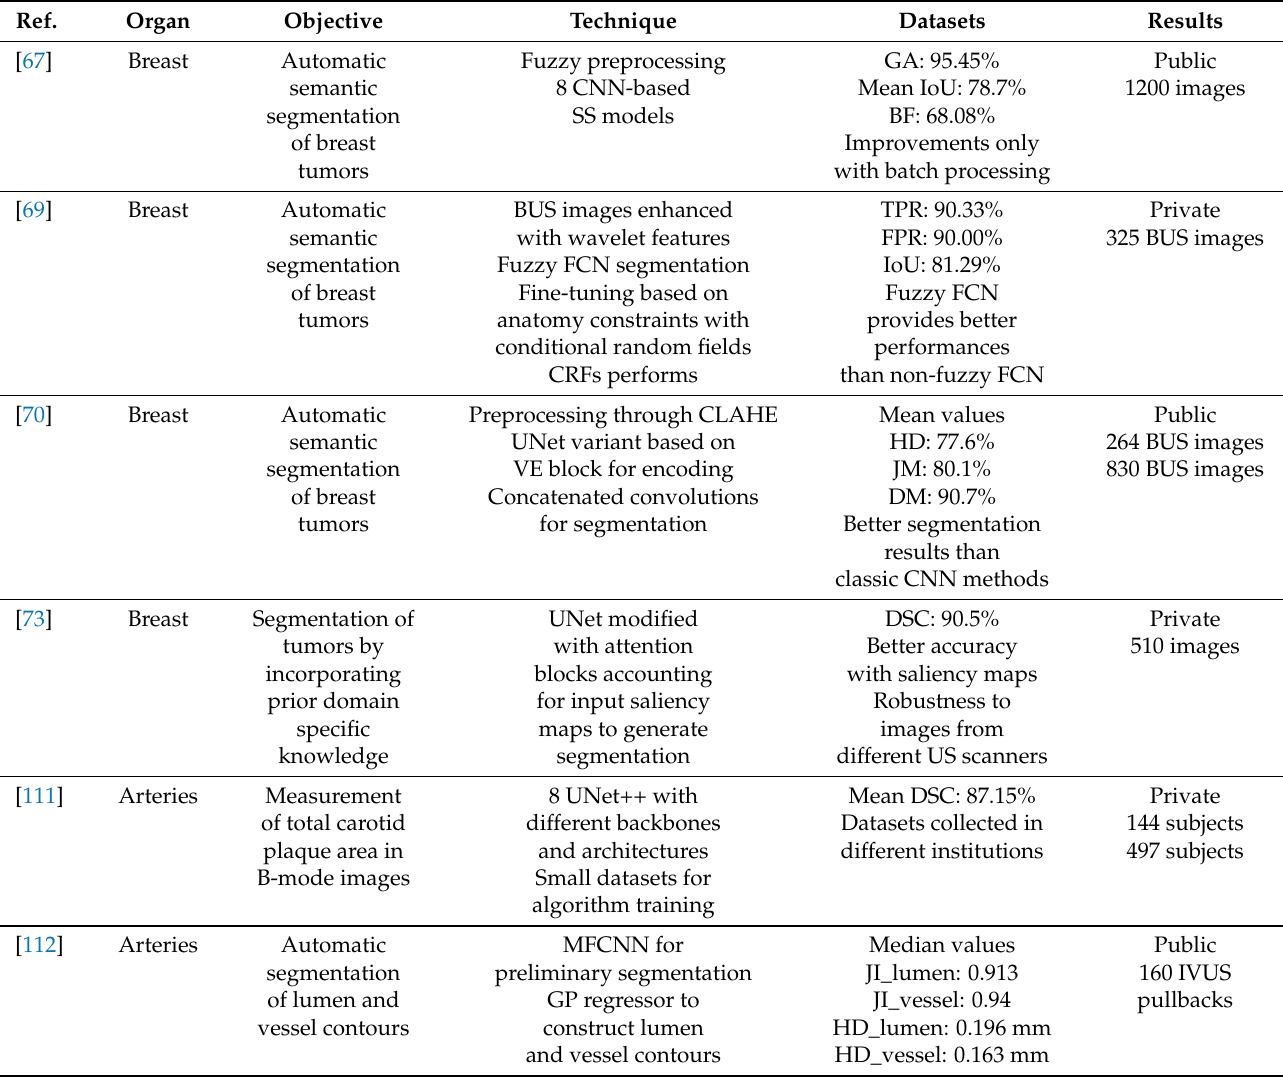
Table 2. Summary of segmentation ML algorithms employed in the studies analyzed related to organ investigated, diagnosis objective, dataset used, and main results achieved.